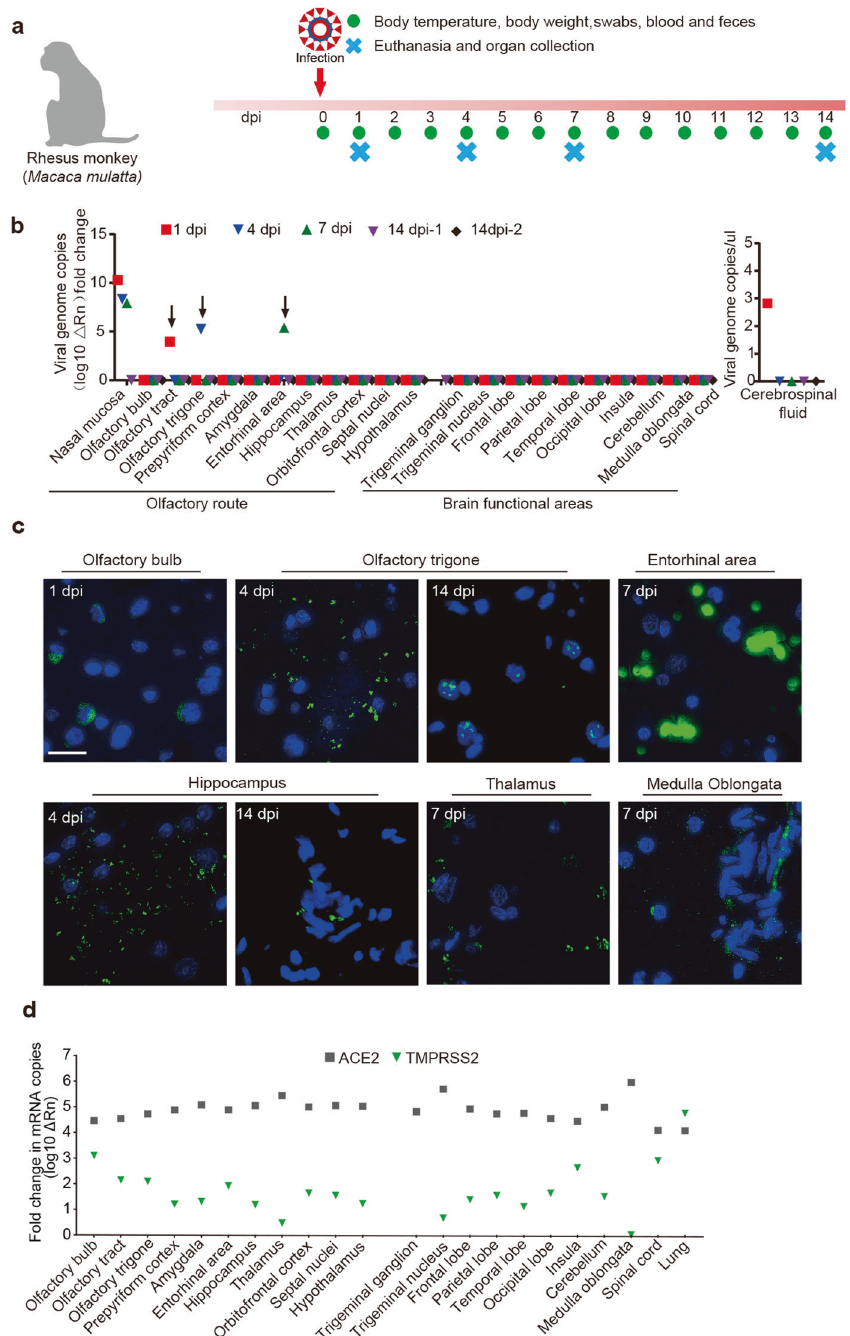
Fig. 1 SARS-CoV-2 invades the CNS in rhesus monkeys post intranasal inoculation. a Scheme of the experimental design of intranasal SARS- CoV-2 inoculation. Five rhesus monkeys (3 – 5 years old) were intranasally inoculated with 1 × 10 7 PFU of SARS-CoV-2 in 1 mL PBS. Monkeys were observed for clinical signs, including body temperature, body weight, sample collection, chest radiograph, and necropsies as indicated. b Viral load in CNS tissues from SARS-CoV-2-inoculated rhesus macaques. On 1, 4, 7, and 14 dpi, animals were necropsied and tissue samples in the CNS were collected. Viral genomic RNA was quantitated by quantitative real-time polymerase chain reaction (qRT-PCR). c Immuno fl uorescence (IF) staining of viral N protein (green) in CNS tissues from rhesus macaques infected with SARS-CoV-2. The sections were counterstained with DAPI for nuclei. Each data point represents an independent fi eld of view from slides subjected to IF. Scale bar, 50 μ m. d qRT-PCR analysis of angiotensin-converting enzyme 2 (ACE2) and TMPRSS2 mRNA expression in the brain tissues from consideration of the cellular heterogeneity. We analyzed the tissues collected on the 4 and 7dpi following intranasal inocula- tion and on the 9 dpi following intracranial inoculation. Two thousand cells were used to create fi ve different clusters, including